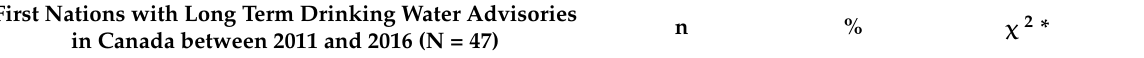
Table 1. Suicide Distributions for First Nations with Long Term Drinking Water Advisories (LT- DWAs) Across Canada Compared to Reported National Proportion of First Nations with Suicide Between 2011 and